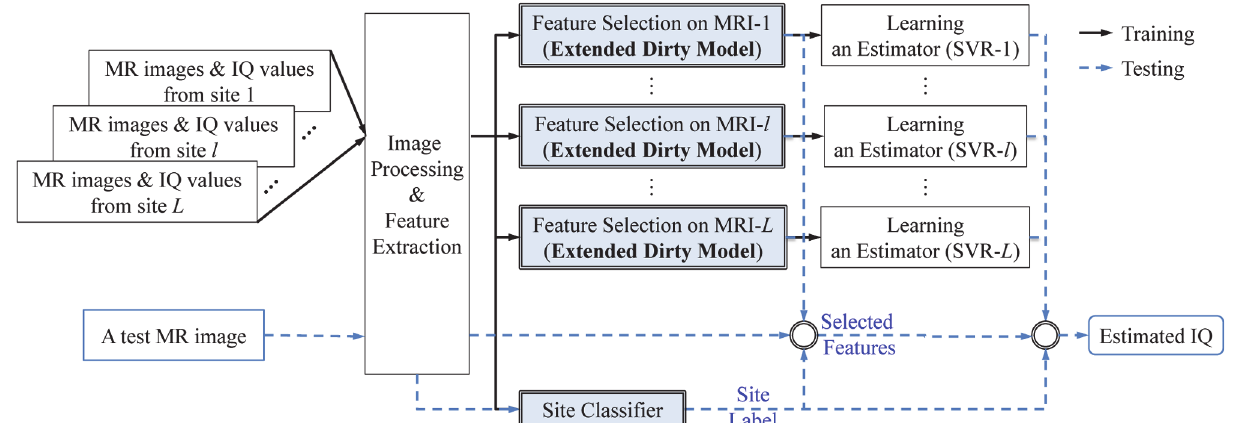
Fig 1. A schematic diagram of the proposed IQ estimation framework using structural MRI